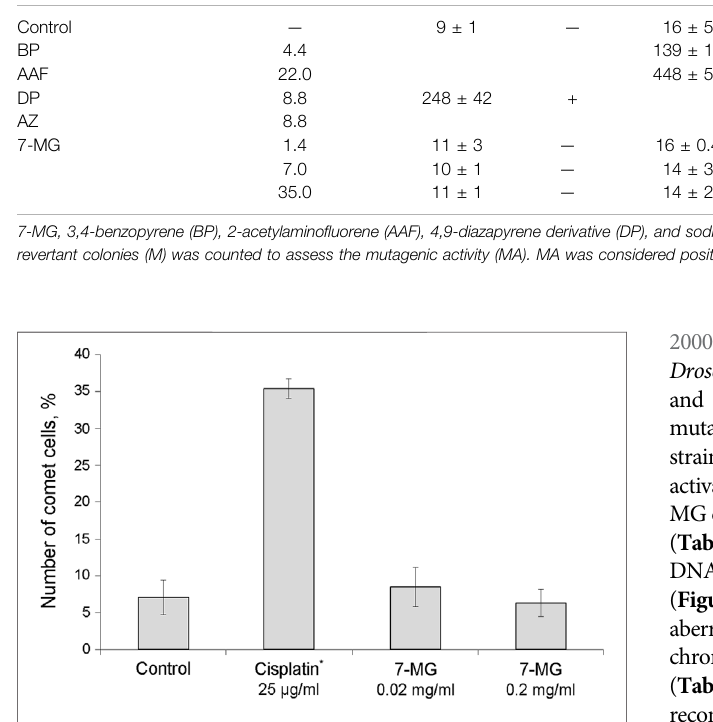
FIGURE2| Studyoftheabilityof7-MGtoproduceDNAstrandbreaksin immortalized human kidney epithelial cells using the comet assay (500 cells were analyzed per slide). *Signi fi cant difference from the control cells (Fisher ’ s exact test, p <